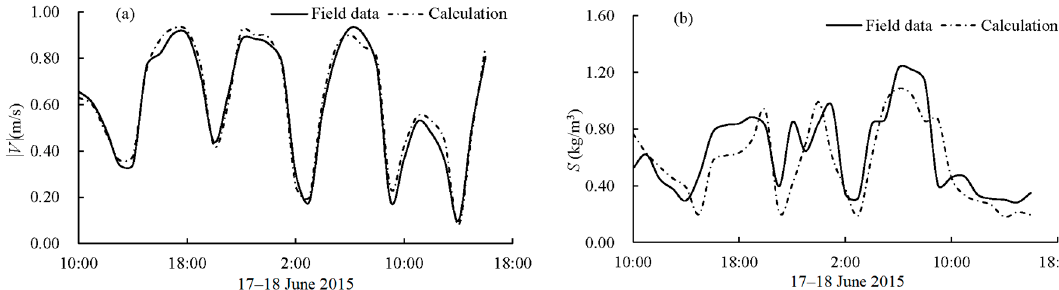
Figure 9. Model calibration, numerical vs. field results at FS2 (spring tide, June 2015): ( a ) |𝑉| ; ( b ) S .